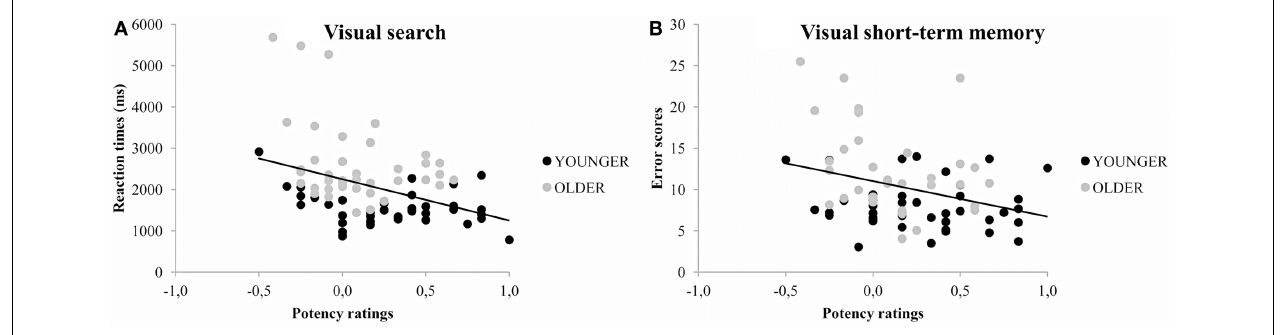
FIGURE 4 | Scatterplots for potency ratings and emotional behavior tasks, separately for visual search (A) and visual short-term memory (B) performance for angry faces across age. Note. Visual search: r = − 0 . 372; Visual short-term memory: r = − 0 .